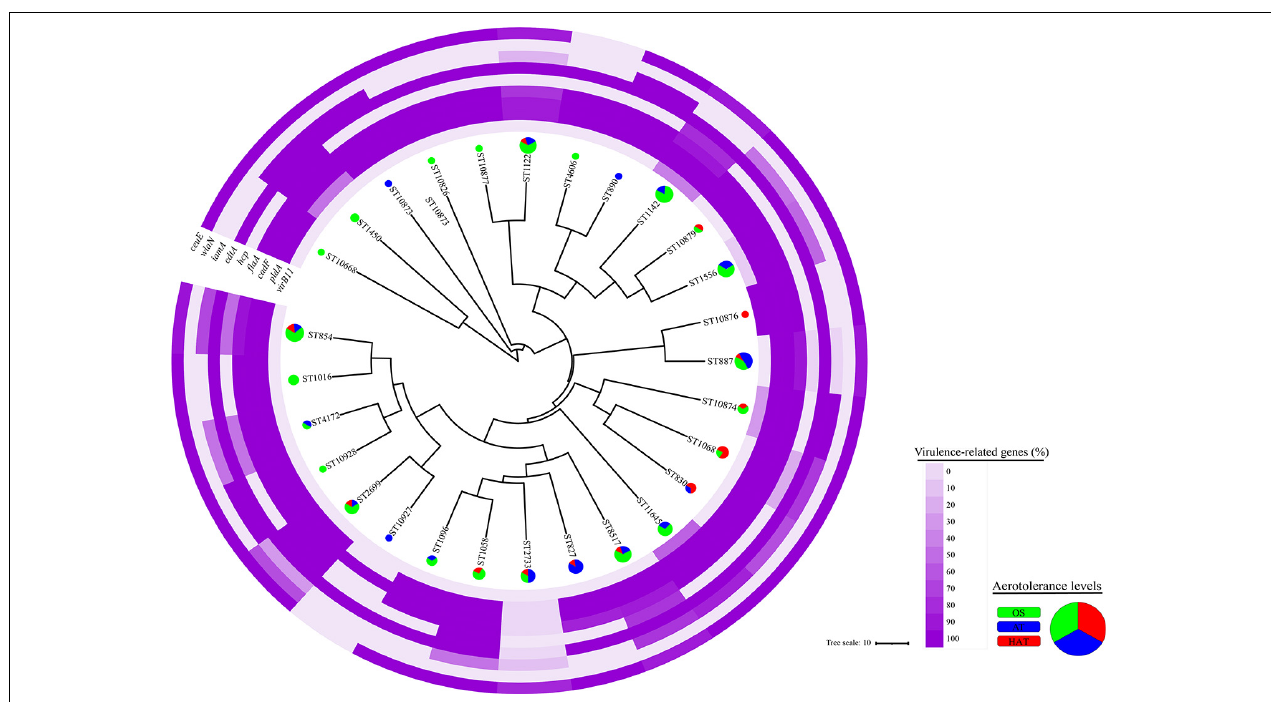
FIGURE 2 | Clonal distribution of 124 Campylobacter coli isolates based on the allelic profiles for the multilocus sequence typing (MLST) housekeeping genes. An unweighted-pair group method with arithmetic mean (UPGMA) dendrogram was constructed based on the allelic profiles of the MLST housekeeping genes for 124 C. coli isolates. The UPGMA dendrogram shows the distribution of the aerotolerance levels and proportions of nine virulence genes of C. coli isolates in each MLST sequence type. Each color in the pie chart indicates an aerotolerance level (green, oxygen-sensitive, OS; blue, aerotolerant, AT; and red, hyper-aerotolerant, HAT) of C. coli